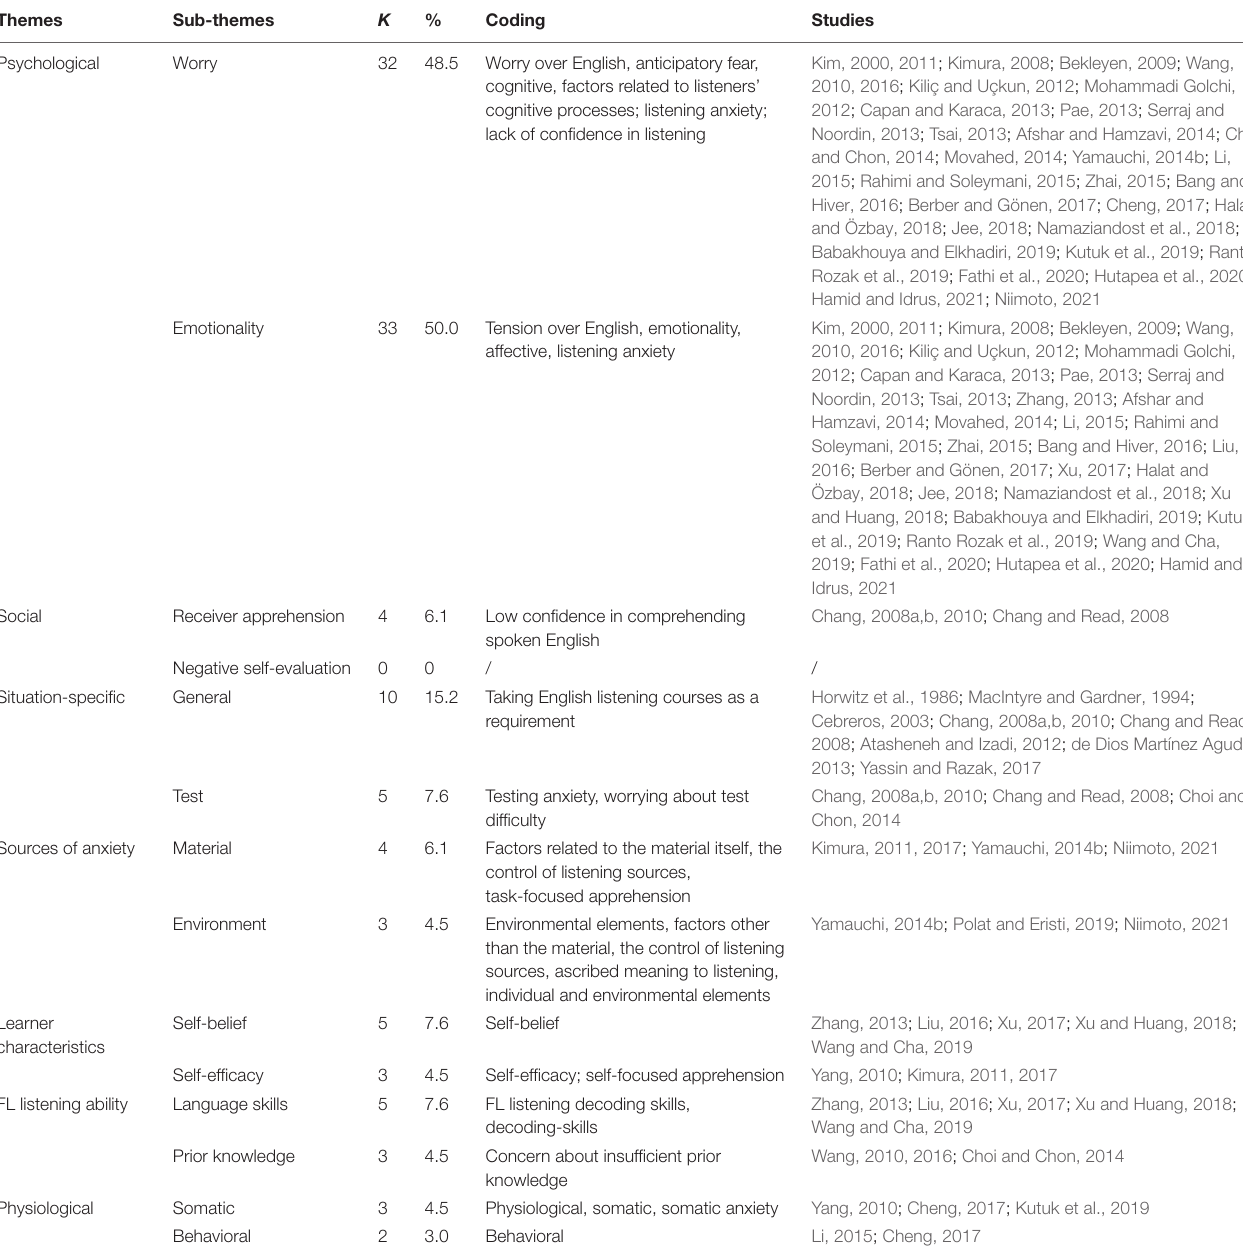
TABLE 3 | The dimensionality of FL listening anxiety scales and the measurements of FL listening anxiety under various approaches. Themes